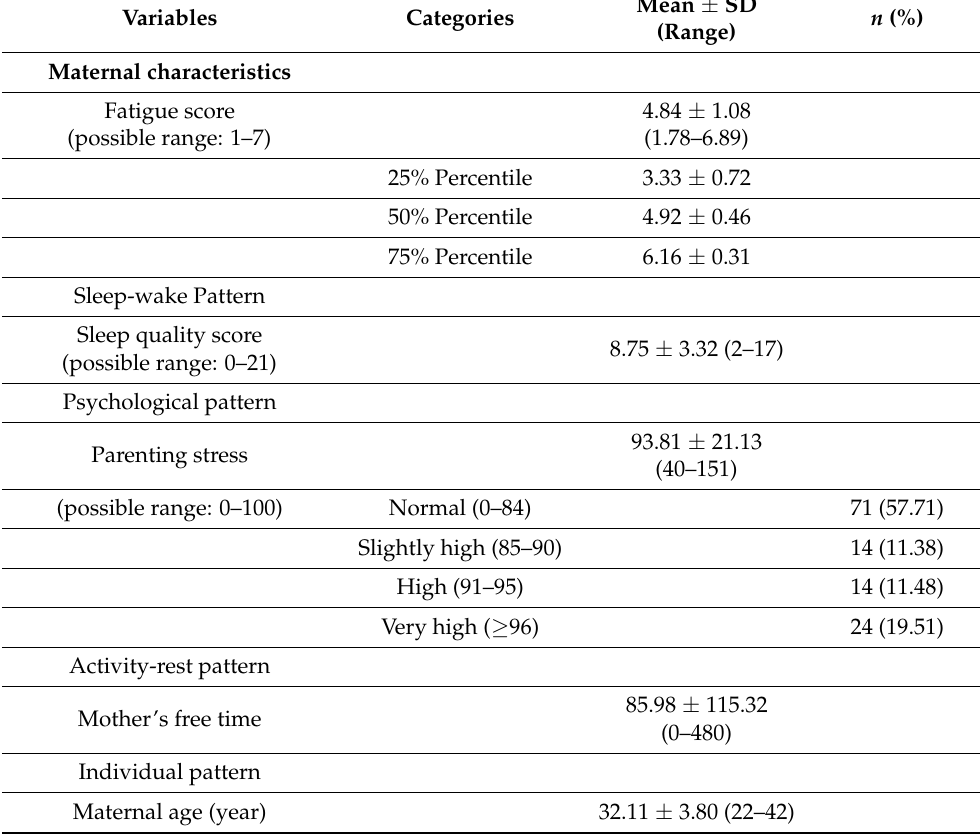
Table 1. General Characteristics ( n =